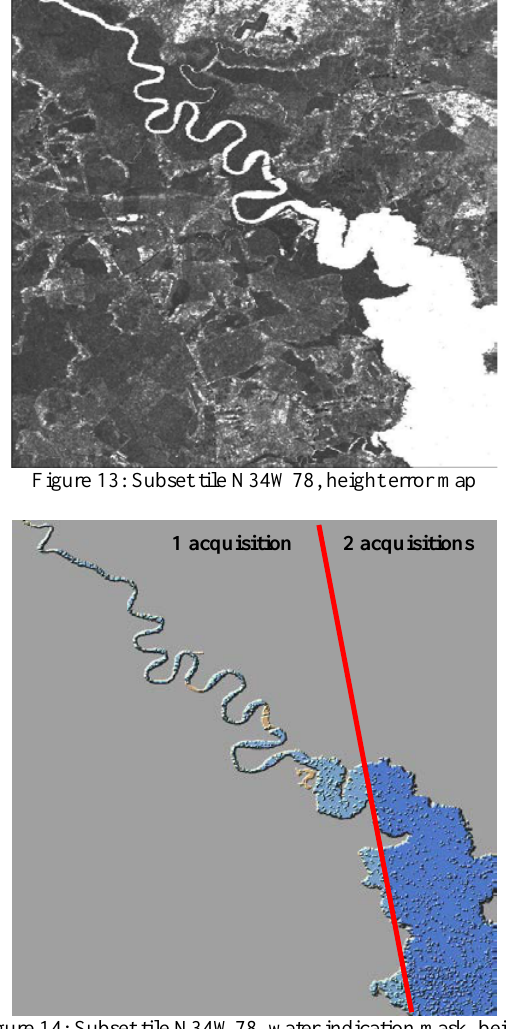
Figure 14: Subset tile N34W78, water indication mask, beige: water derived from amplitude, light blue: water derived from amplitude and coherence, dark blue: water derived from amplitude and coherence in two